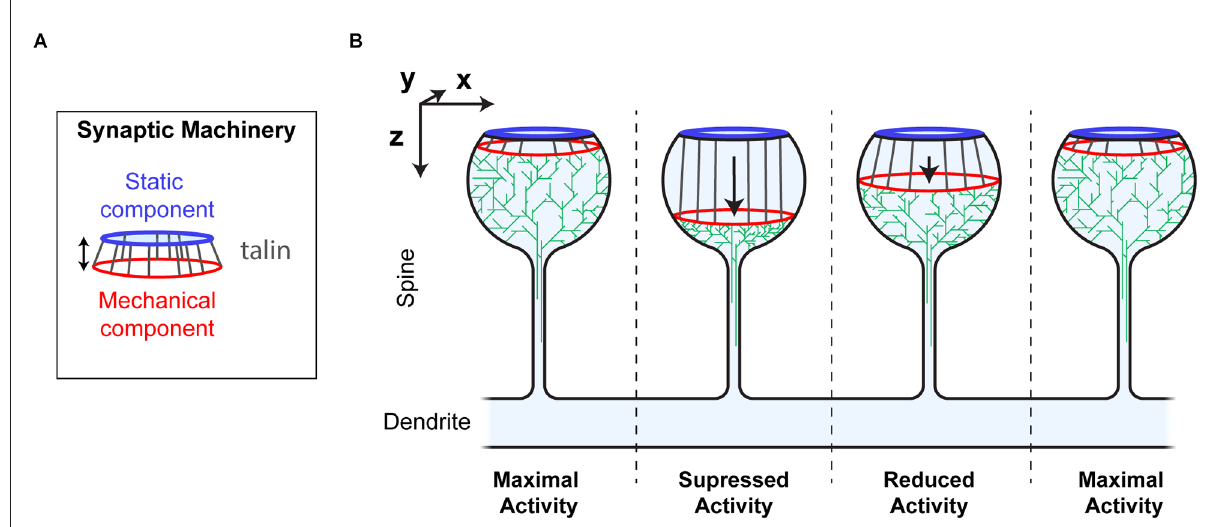
FIGURE7 Synaptic Gearbox hypothesis of a dynamically tuneable, binary-encoded mechanism for graduated synaptic activity. (A) The synaptic machinery can be divided into two ordered parts, (i) a static component at the active zone/PSD (blue) and a mechanically operated component (red) connected by the MeshCODE (grey). The graduated nature of the MeshCODE switch states means that synaptic activity can be dynamically regulated by moving the two parts of the machinery relative to each other in quantised steps. (B) Despite having similar molecular compositions, the four synapses illustrated are shown as having different activation states because the molecules in the synapse are ordered differently due to different MeshCODE patterns. Mechanical signals that change the MeshCODE patterns will re-organise the synaptic machinery and dynamically tune up or down the synaptic activity. In this way every synapse in the organism can be mechanically synchronised by altering the binary coding within